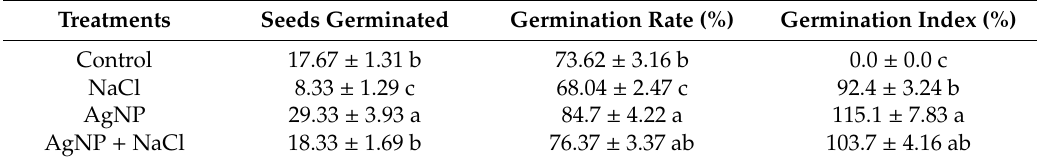
Table 1. Average number of seeds germination, germination rate (%), and germination index (%) in wheat ( Triticum aestivium ) seedlings exposed to 100 mM salt stress and supplemented with silver nanoparticle (300 ppm; AgNP) at 20 days after sowing (DAS). Data followed by the same letter are not significantly different by LSD test at ( p < 0.05).